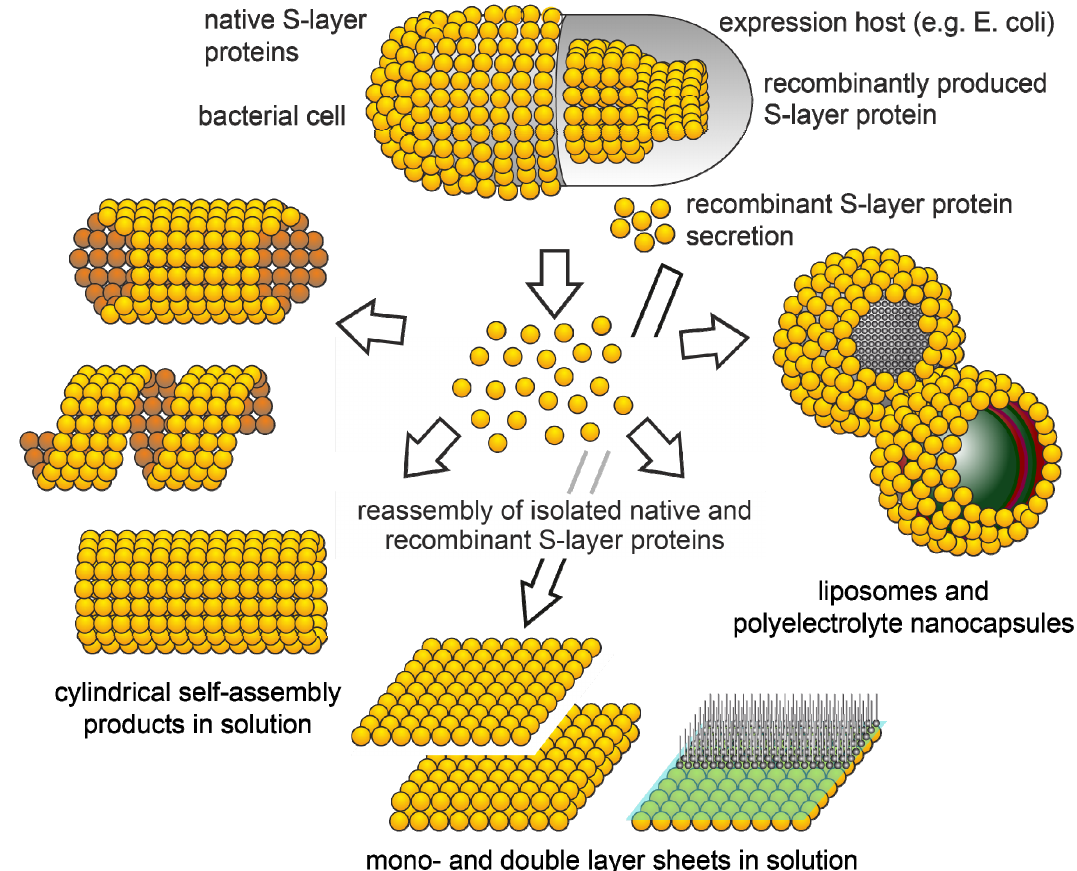
Figure 3. Schematic drawing showing the reassembly of S-layer proteins in solution, on solid supports, at the air-water interface, at lipid films, and at liposomes and